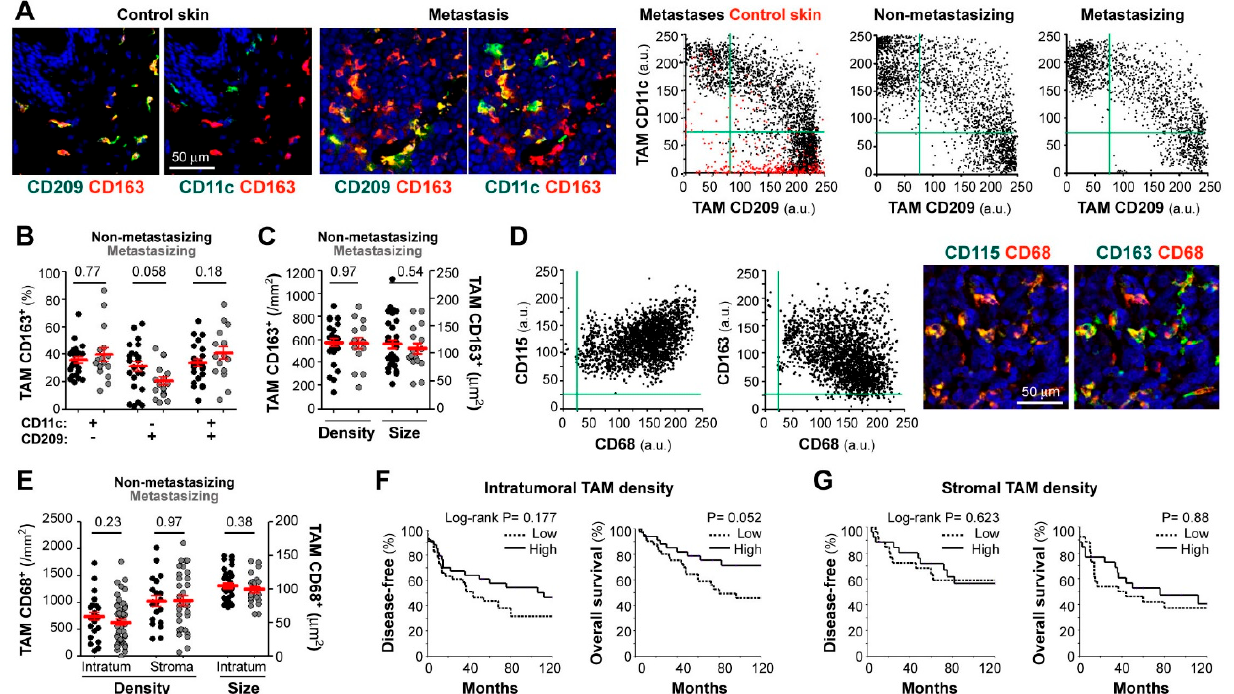
Figure 1. Correlation between patient evolution and TAM density, size, and polarization state. Confocal microscopy screening of two independent and differently preserved primary melanoma collections: frozen (stage I-III; ( A – C )) and FFPE (stage II-IV; D – G ). ( A ) Frozen tissues co-stained for CD163 (red) and CD11c or CD209 (green), as indicated. Dot-plots show single-cell MFI (arbitrary units, a.u.) for CD11c and CD209 proteins simultaneously quantified at CD163 + TAMs in control skin ( n = 3, red dots), skin metastases ( n = 6), non-metastasizing ( n = 24) and metastasizing ( n = 11) primary melanomas. ( B ) Relative percentages of polarized TAMs through the whole cryopreserved primary collection ( n = 40). ( C ) Average density (by mm 2 ) and size ( µ m 2 ) of CD163 + TAMs quantified through intratumoral and/or peritumoral regions of primary melanomas ( n = 40). ( D ) Paraffin-embedded melanoma co-stained for pan-macrophage markers CD68 (red) and CD163 or CD115 (green), as indicated. Dot-plots show single-cell expression of CD68 vs. CD115 or CD163 proteins quantified in either CD68 + , CD163 + and/or CD115 + TAMs ( n = 3 non-metastasizing and 3 metastasizing primary melanomas). ( E ) CD68 + TAM density quantified through intratumoral ( n = 83) and stromal ( n = 54) areas of primary melanomas. TAM size at intratumoral regions ( n = 83), are shown. ( F , G ) Correlation between patient evolution and CD68 + TAM density at intratumoral ( F ) and stromal ( G ) regions. Disease-free and overall survival 10-year Kaplan–Meier curves are shown. Cut-off values were calculated from ROC curves to classify as ‘low’ or ‘high’ density. p values are shown (Log-rank). Mann-Whitney statistical analysis was used to compare non-metastasizing vs. metastasizing melanomas in ( B , C , E ) panels. Scale bars, 50 µ